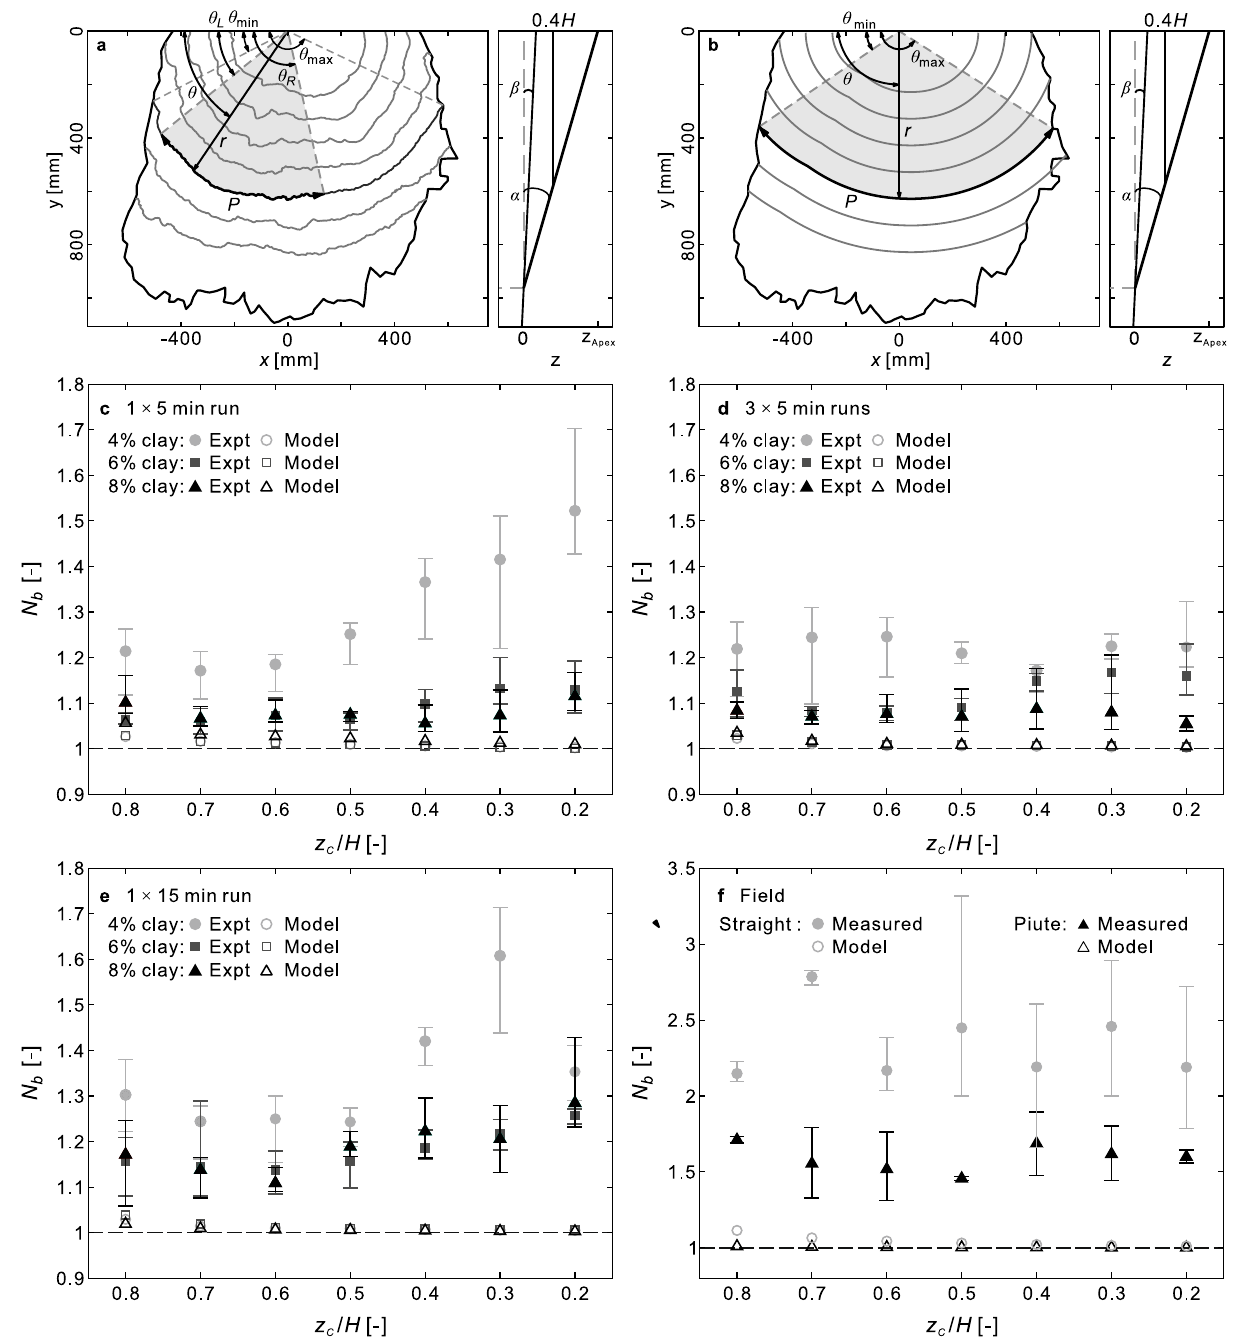
Figure 4. Complexity measurements. ( a,b ) Illustrative contours and complexity-related variables from ( a ) the experimental fan with 4% clay and 3 5 min runs. ( b ) A constant-slope modelled fan using the same fan apex × position and median slope. ( a,b ) Left panels: top view showing each fan boundary (black outer line); contours of z apex (gray lines). ( a,b ) right panels: center vertical cross-section elevation for z c from 0.2 H , to 0.8 H , where H = (with distorted z scale). Black lines: bed plane of slope tan β and approximate fan surface of slope tan α ; dashed 0 ; bold line: contour plane z line: horizontal plane of z c =0.4 H . ( c – f ) complexity measurements from the = experimental and field alluvial fans, modeled and measured, as noted in the upper left corners. open symbols: modelled fans; closed symbols: mean N b of the measured fans. Error bars represent range of N b values for 6 smaller sections of each contour of the measured fans and 2 smaller sections for each field